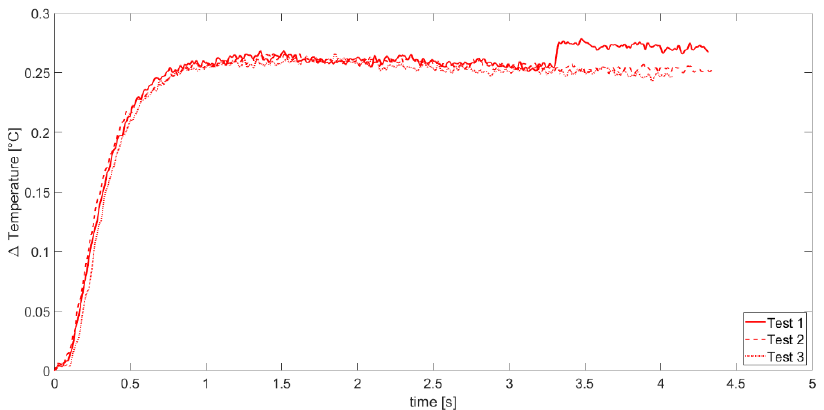
Figure 12. APS: relative temperature ∆ Temperature .